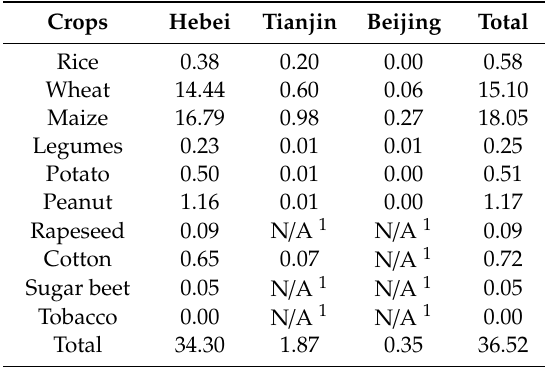
Table 3. Crops residues in 2017 (10 6 tons).